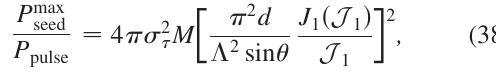
¼ c(cid:1) cot (cid:2) is o